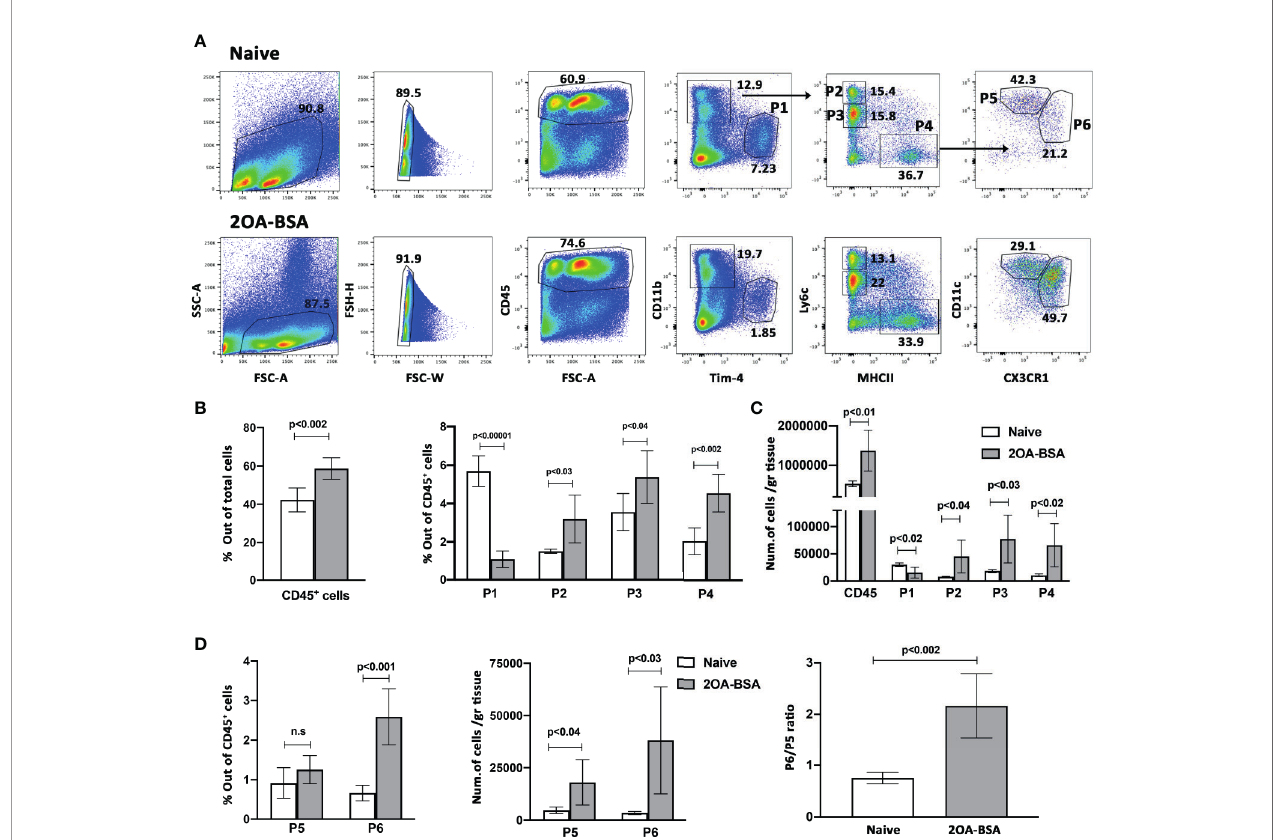
FIGURE 1 | Monocyte and monocyte-derived macrophages become the dominant subset of MNPs in the liver following induction of autoimmune cholangitis. (A) Representative fl ow cytometry analyses of puri fi ed non-parenchymal liver cells from naïve mice (upper panel) and 2OA-BSA immunized mice 8 weeks following immunization (lower panel). (B) Graphical summary of fl ow cytometry analysis of non-parenchymal liver cells; left graph summarizes the percentages of CD45-positive cells out of total cells and the right graph summarizes the percentages of each cell population out of CD45-positive cells. (C) Graphical summary of cells numbers normalized for liver tissue mass for CD45-positive cells and P1-P4 cell subsets. (D) Graphical summary of fl ow cytometry analysis showing the percentages of P5 and P6 cell populations out of CD45-positive cells (left panel), absolute cell numbers of P5 and P6 cell populations normalized for liver tissue mass (middle panel), and P6/P5 ratio (right panel), in naïve mice vs. 2OA-BSA immunized mice 8 weeks post immunization. Results presented as mean ± SEM (n ≥ 5) for each group. Results are representative of two independent experiments. p values < 0.05 were considered as signi fi cant (unpaired Student ’ s t